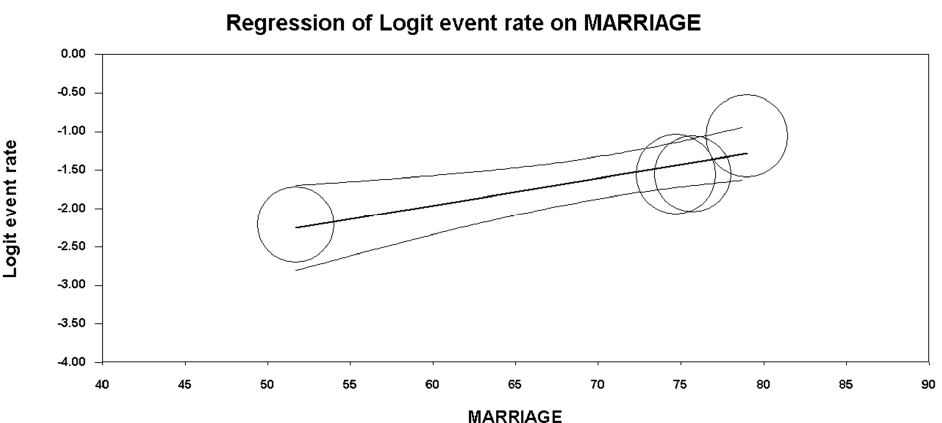
Figure 4. Meta-regression analysis for marriage (in percentage) among truck-drivers, showing that there is a statistically significant association between marital status and binge drinking (i.e., a higher marriage percentage correlated with a lower binge drinking pattern rate). Int. J. Environ. Res. Public Health 2018, 15, x FOR PEER REVIEW